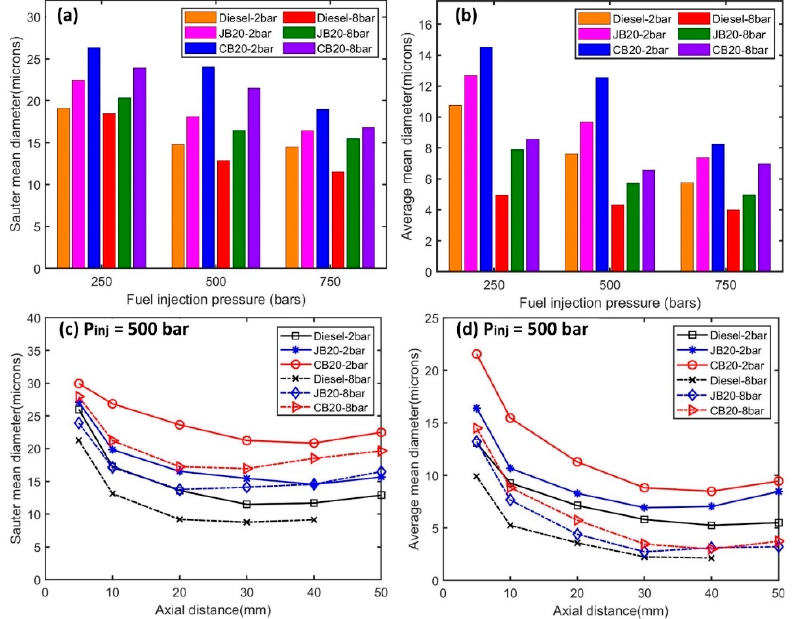
Figure 10. Numerical results for ( a ) SMD and ( b ) AMD at three different injection and two different ambient pressures, respectively. ( c ) SMD and ( d ) AMD with respect to various axial positions at 500 bar IP.